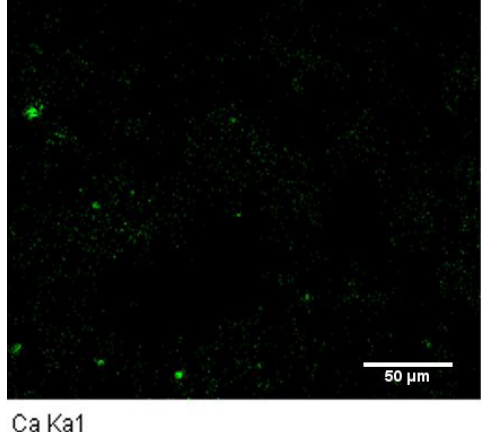
Figure 4. Calcium dispersion in Macusanite through EDS.